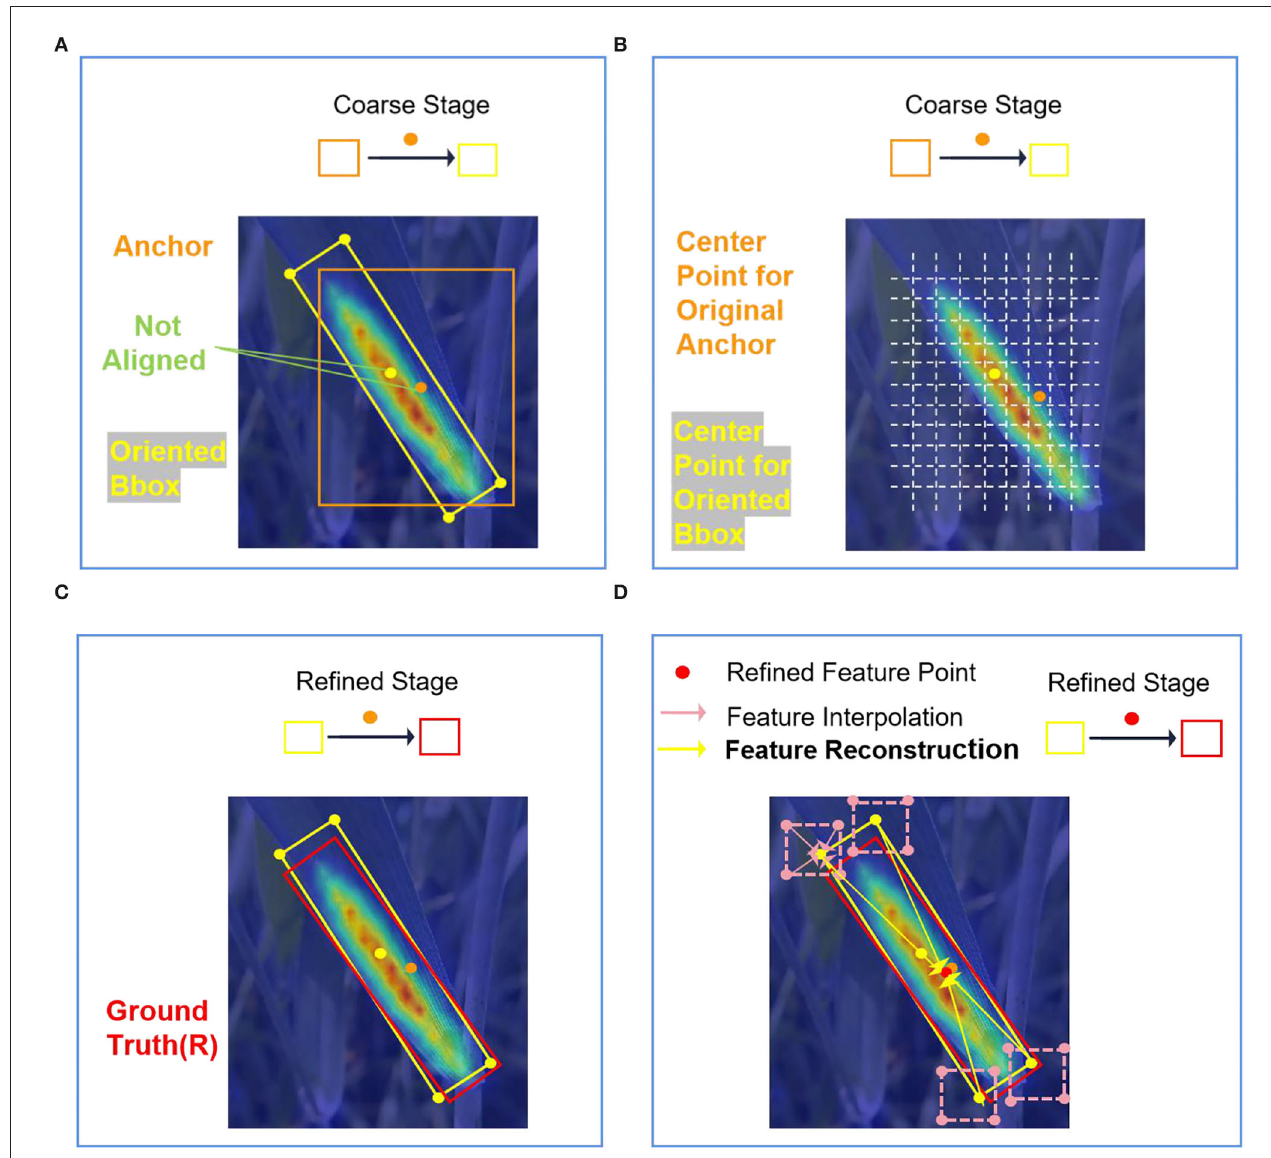
FIGURE 8 | Feature misalignment and the core idea for FRM. (A) Feature misalignment of the coarse stage; (B) location of center points for original horizontal anchor and refined anchor in the feature grid; (C) not aligned feature is used in the refined stage; and (D) aligned features are used in the refinement stage by reconstructing the feature